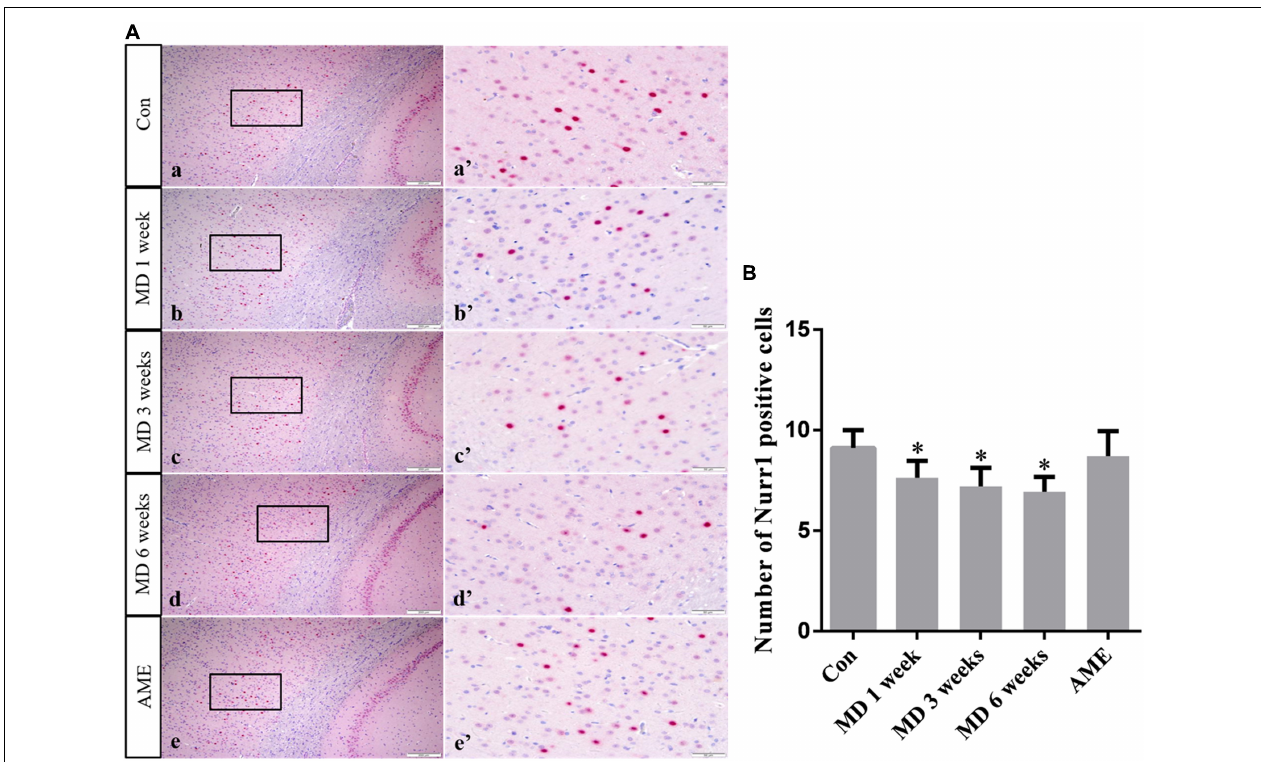
FIGURE 8 | (A) Representative images showing Nurr1 immunohistochemistry in the cortex. Panels (a’–e’) are magnified areas of panels (a–e) . Bars = 200 µ m in panels (a–e) . Bars = 50 µ m in panels (a’–e’) . (B) Quantitative analysis of the number of Nurr1 positive cells. The data are shown as mean ± SD, ∗ P < 0.05 vs. control group ( n = 6). MD, morphine dependence; AME, acute morphine